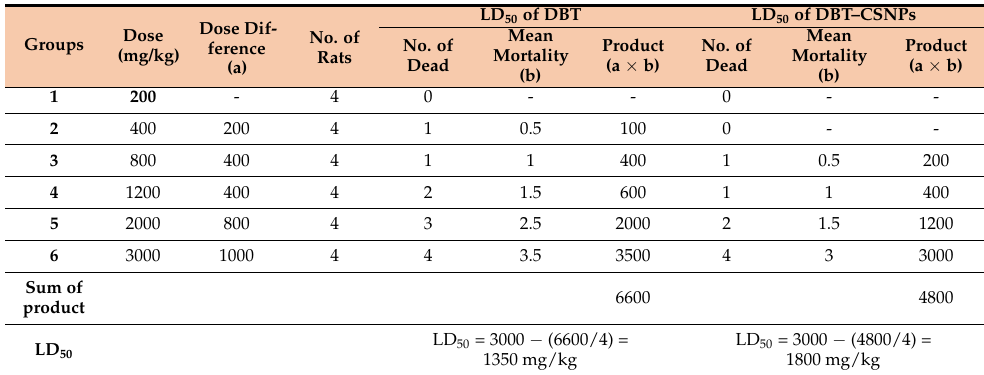
Table 1. Karber’s method for the determination of the LD 50 of DBT and DBT–CSNPs in rats.